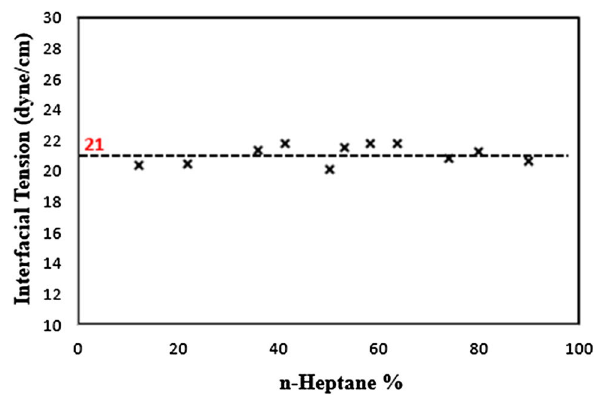
Fig. 16 IFT between water and light oil–heptane mixture (Mousavi- Dehghani et al. 2004)